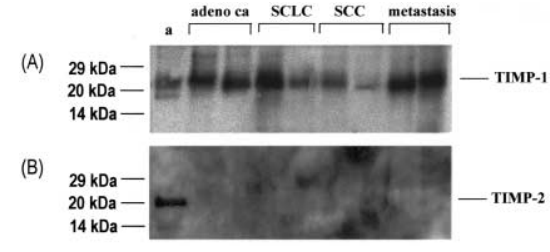
Western blot analysis for expression of TIMP-1 (panel A) and TIMP-2 (panel B) in bronchial washings obtained from the same samples analysed for MMP activity as presented in panel 1 A. Recombinant human TIMP-1 or TIMP-2 are presented in lane